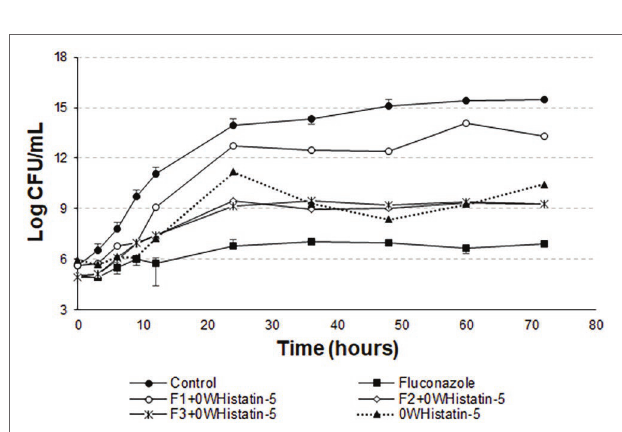
FIGURE 5 | Time-kill curves for C. albicans (ATCC 90028) treated with extruded F1, F2, and F3 loaded with 0WHistatin 5. The lines referring to F1 + 0WHistatin 5, F2 + 0WHistatin 5, and F3 + 0WHistatin 5 systems are overlapping because the number of counted colonies were close.